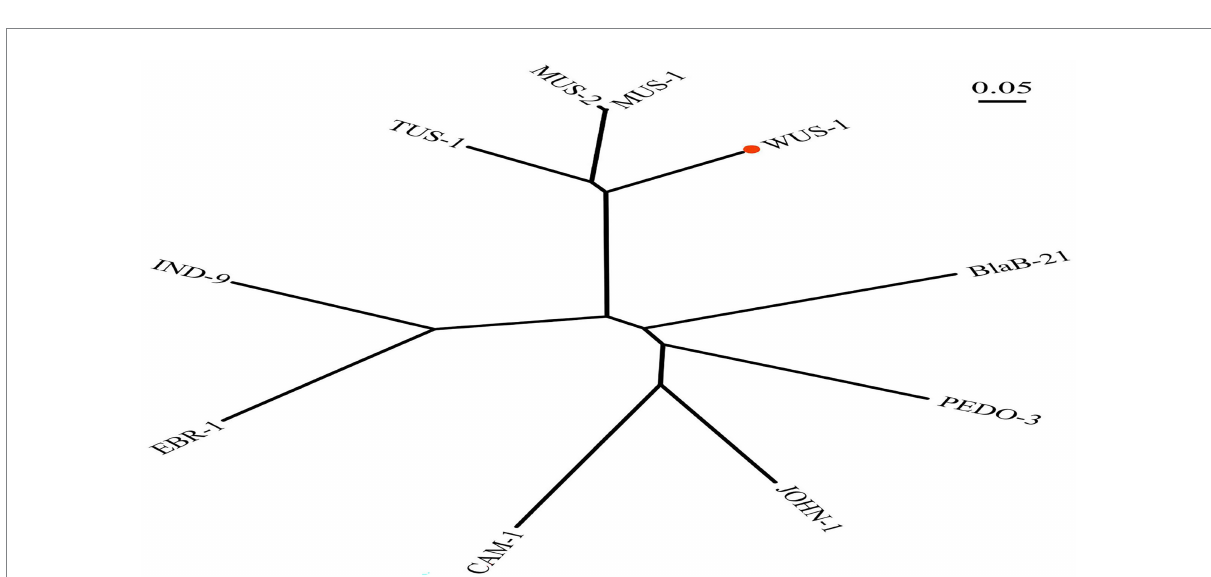
FIGURE 1 Phylogenetic tree showing the relationship of WUS-1 to other class B β -lactamases. WUS-1 from this study is marked with a red dot. The sequences and their accession numbers are as follows: MUS-1 (AAN63647.1), MUS-2 (AKN19901.1), TUS-1 (AAN63648.1), IND9 (ACZ65153.1), EBR- 1 (AAN32638.1), CAM-1 (AVX51087.1), JOHN-1 (AAK38324.1), PEDO-3 (AJP77076.1), and BlaB-21